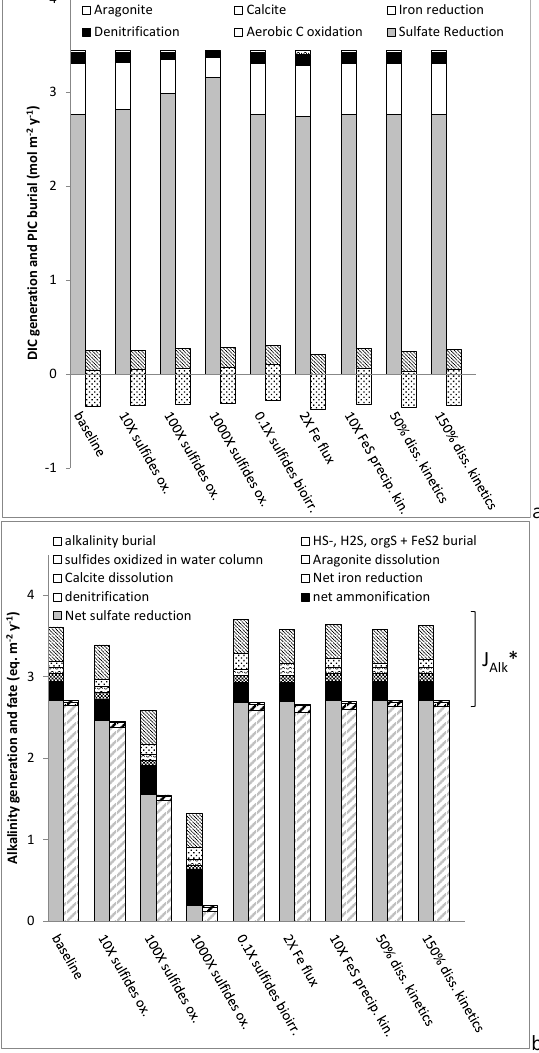
Fig. 6. Model output DIC (a) and alkalinity (b) generation sensi- tivity to dissolution kinetics, sulfide bioirrigation, sulfide oxidation kinetics, Fe deposition, and FeS precipitation kinetics. 75m carbon- ate shelf environment.